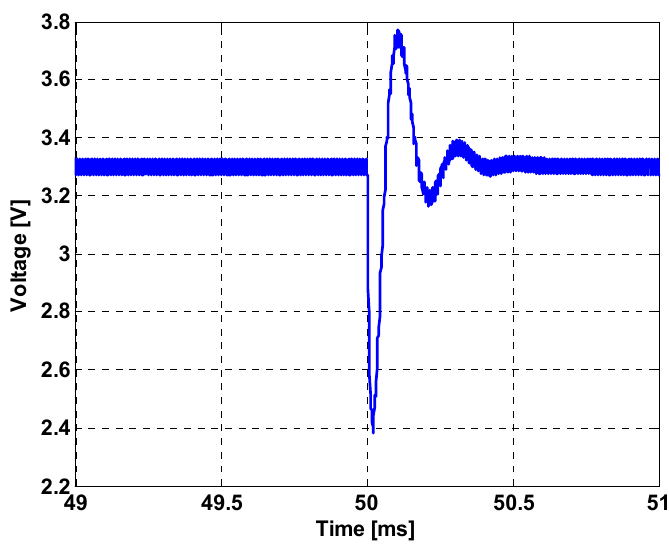
Figure 10. Load regulation performance (20 kHz).